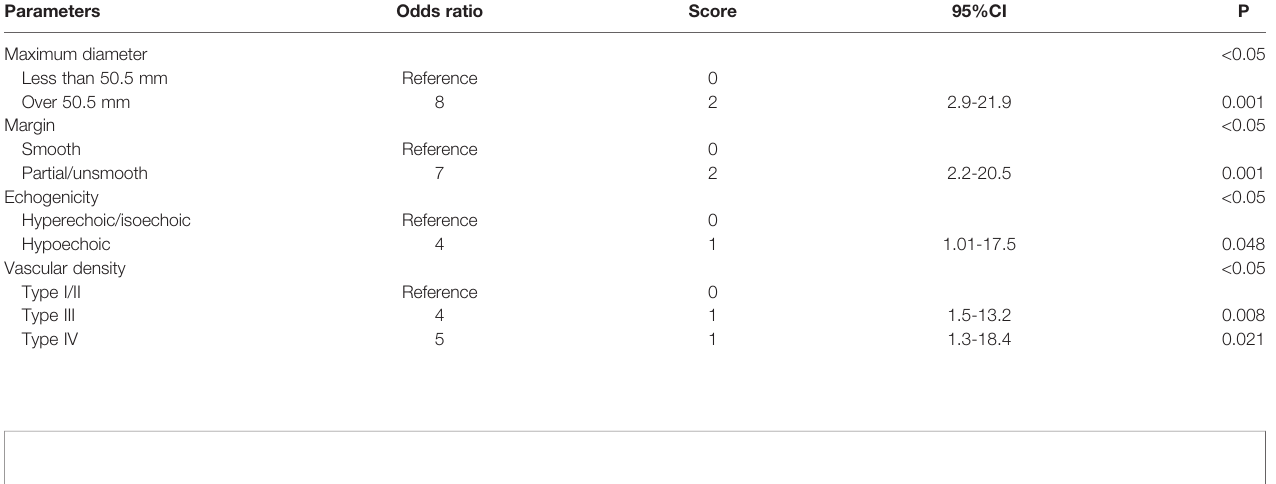
TABLE 2 | Multivariate logistic regression model with odds ratios composed of independent factors in